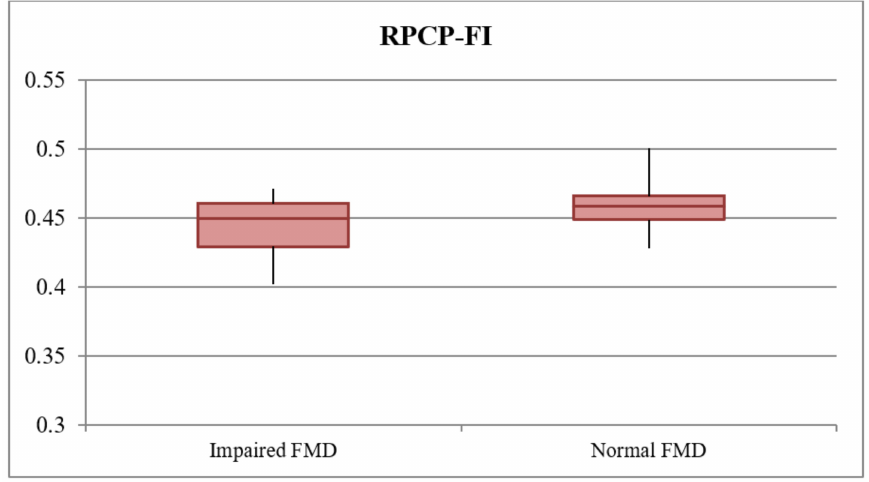
Figure 5. Radial peripapillary capillary plexus flow index (RPCP-FI) values in the impaired (flow- mediated dilation) FMD and normal FMD subgroups. Box plot showing the distribution of the RPCP-FI values in the impaired FMD and normal FMD subgroups.